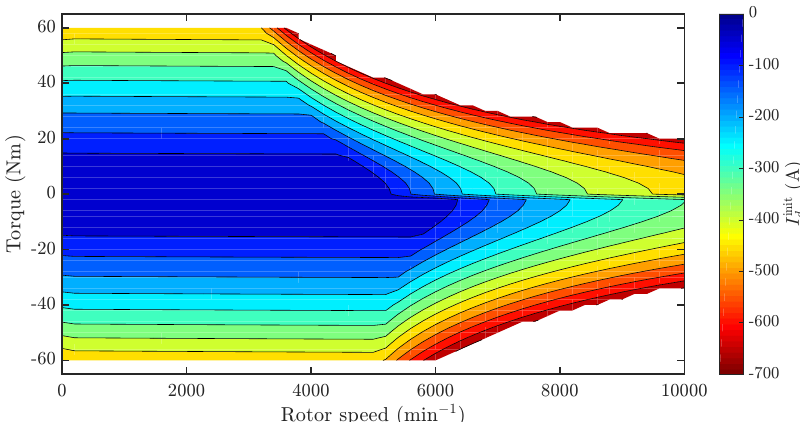
Figure 12. Initial current I init